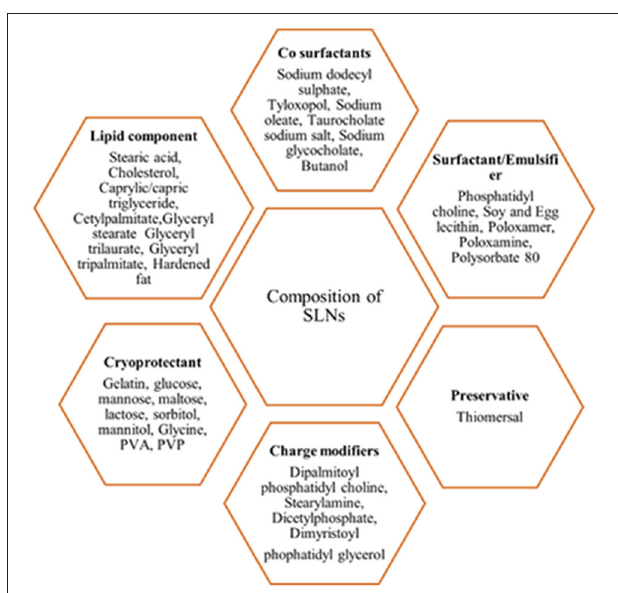
FIGURE 4 | Composition of the